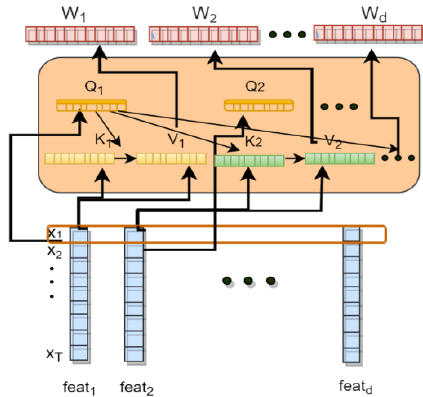
Figure 2. The relational model diagram of feature dimensions was